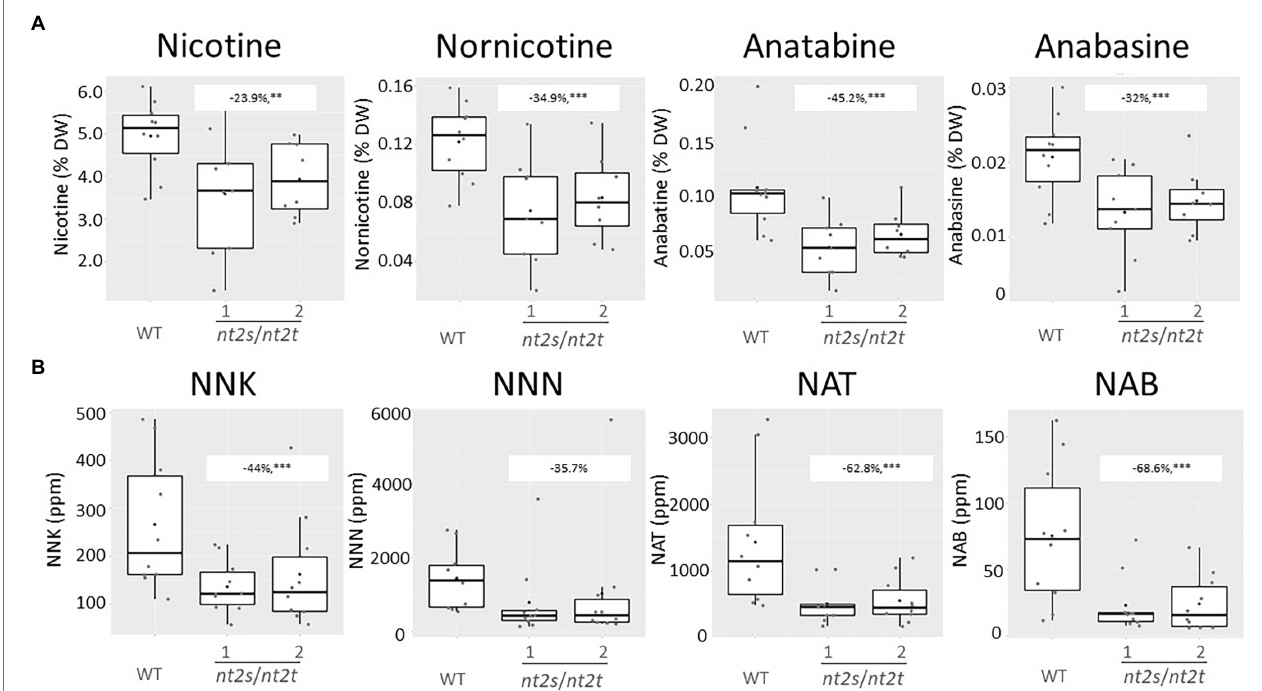
FIGURE 7 | Alkaloid (nicotine, nornicotine, anatabine, and anabasine; A ) and TSNA (NNK, NNN, NAT, and NAB; B ) content in the cured leaf lamina of WT and CLC-CRISPR–Cas9 KO double-mutant plants (nt2s/nt2t lines 1 and 2) grown in the field. Data were collected from 10 plants randomly selected after curing. The charts represent boxplots of the genotypic groups. For nicotine levels, the difference observed between the WT and nt2_s/nt2_t lines was − 23.9% ( − 9.1, − 38.6%), p = 0.010**; for nornicotine levels, the difference observed between the WT and nt2_s/nt2_t lines was − 34.9% ( − 17.8, − 52%), p = 0.002***; for anatabine levels, the difference observed between the WT and nt2_s/nt2_t lines was − 45.2% ( − 24.4, − 65.9%), p = 0.001***; for anabasine levels, the difference observed between the WT and nt2_s/nt2_t lines was − 32% ( − 14.1, − 50%), p < 0.005***. In case of the TSNAs, for NNK levels, the difference observed between the WT and nt2_s/nt2_t lines was − 44% ( − 17, − 70.9%), p = 0.009***; for NNN levels, the difference observed between the WT and nt2_s/nt2_t lines was − 35.7% ( − 21.8, − 93.2%), p = 0.29; for NAT levels, the difference observed between the WT and nt2_s/nt2_t lines was − 62.8% ( − 33.6, − 91.9%), p = 0.001***; for NAB levels, the difference observed between the WT and nt2_s/nt2_t lines was − 68.6% ( − 37.8, − 99.4%), p = 0.0008***. An ANOVA test with a CI of 90% was